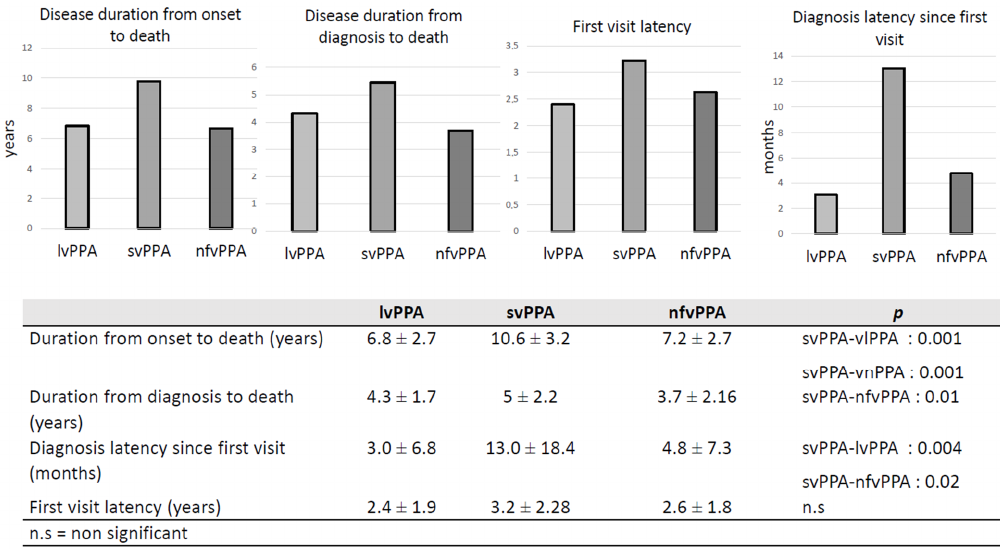
Figure 2. Disease duration.